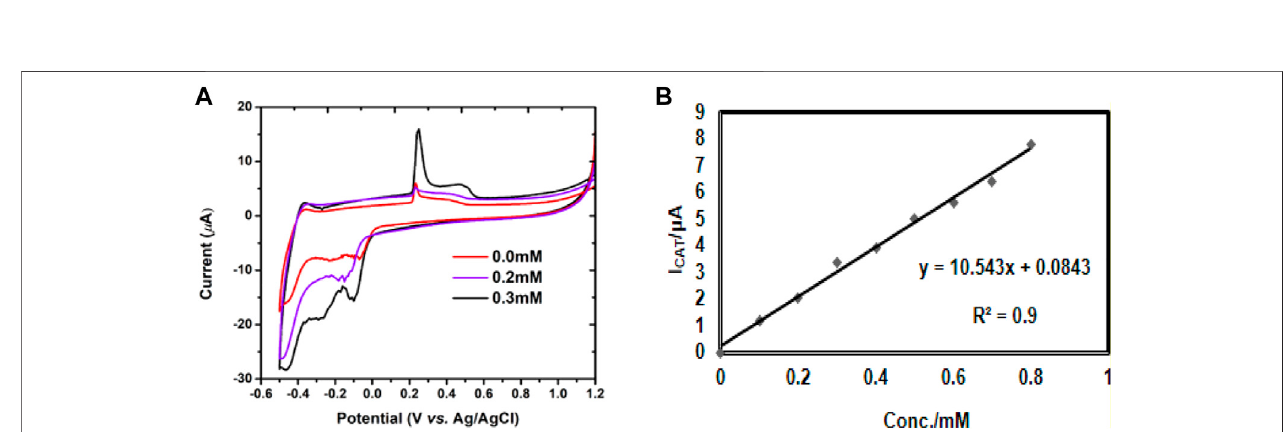
FIGURE 8 | (A) Methyl Parathion catalysis on the P 2 W 18 Polyoxometalate LBL composite fi lms. CV of P 2 W 18 Polyoxometalate-AgNPs multilayer in each step was recorded before adding analyte (black) curve and after adding analyte; (0.2 – 2.0 mM), pH 4.5, and scan rate 10mV/S. (B) Electro-catalytic for detection of methyl parathion on LBL fi lm of P 2 W 18 POM with